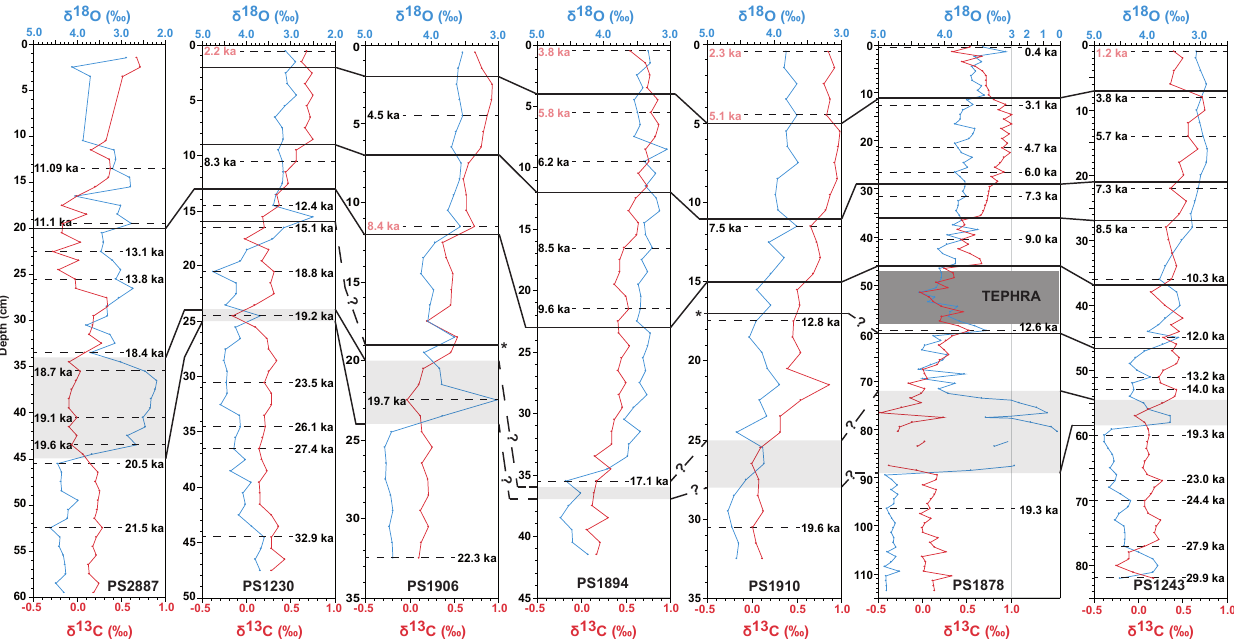
Fig. 2. Planktic oxygen and carbon stable isotope records of cores from the Nordic Seas and suggested correlation. Calibrated AMS 14 C dates are shown. Dates excluded from the correlation are marked in pale red. Light grey shadings indicate the light carbon and oxygen isotope excursions interpreted as freshwater discharges, marking the onset of the